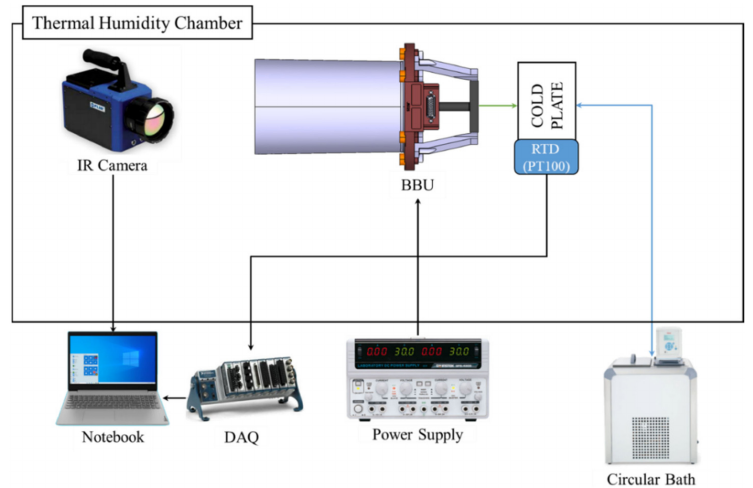
Figure 13. BB heat-up test setup in ambient